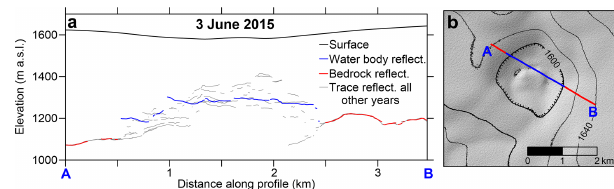
Figure 3. (a) The traced reflections in 2015 (blue and red) for the same section of the RES survey route as in Fig. 2 compared with traced reflections of all other years (grey) from this profile section. This is used to classify traced reflections in 2015 as reflections from the roof of a water body (blue) and bedrock (red). The vertical ex- aggeration is 2-fold. (b) The corresponding classification for 2015 posted on a TanDEM-X DEM in September